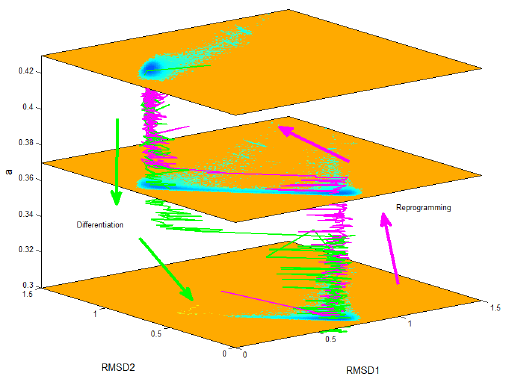
Figure 5. The differentiation and reprogramming trajectories on the landscape background. Z axis represents activation strength a . Three 2-dimensional landscape from up to down separately correspond to a ~ 0 : 43 , a ~ 0 : 37 and a ~ 0 : 3 . Green color represents differentiation trajectory (from stem cell state to differentiation state), and magenta color represents reprogramming trajectory (from differentiation state to stem cell state).